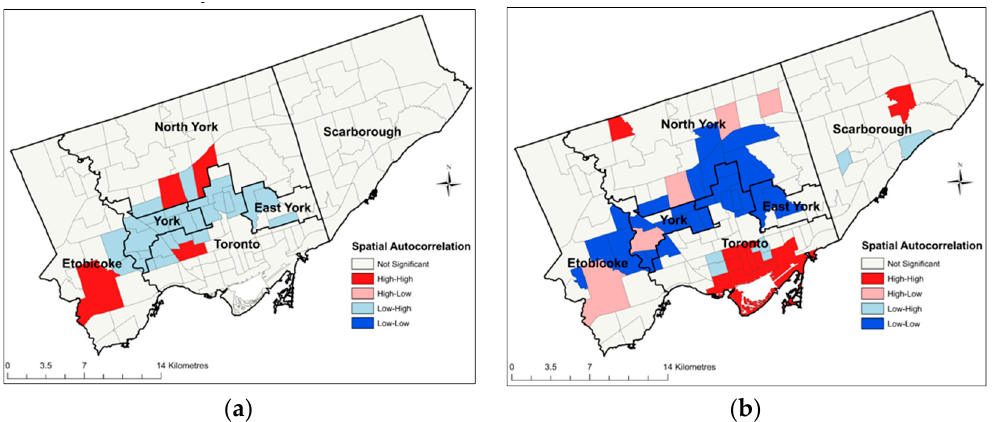
Figure 2. ( a ) LISA Statistics Map for Property Crime, 2014–2016. ( b ) LISA Statistics Map for Violent Crime, 2014–2016.